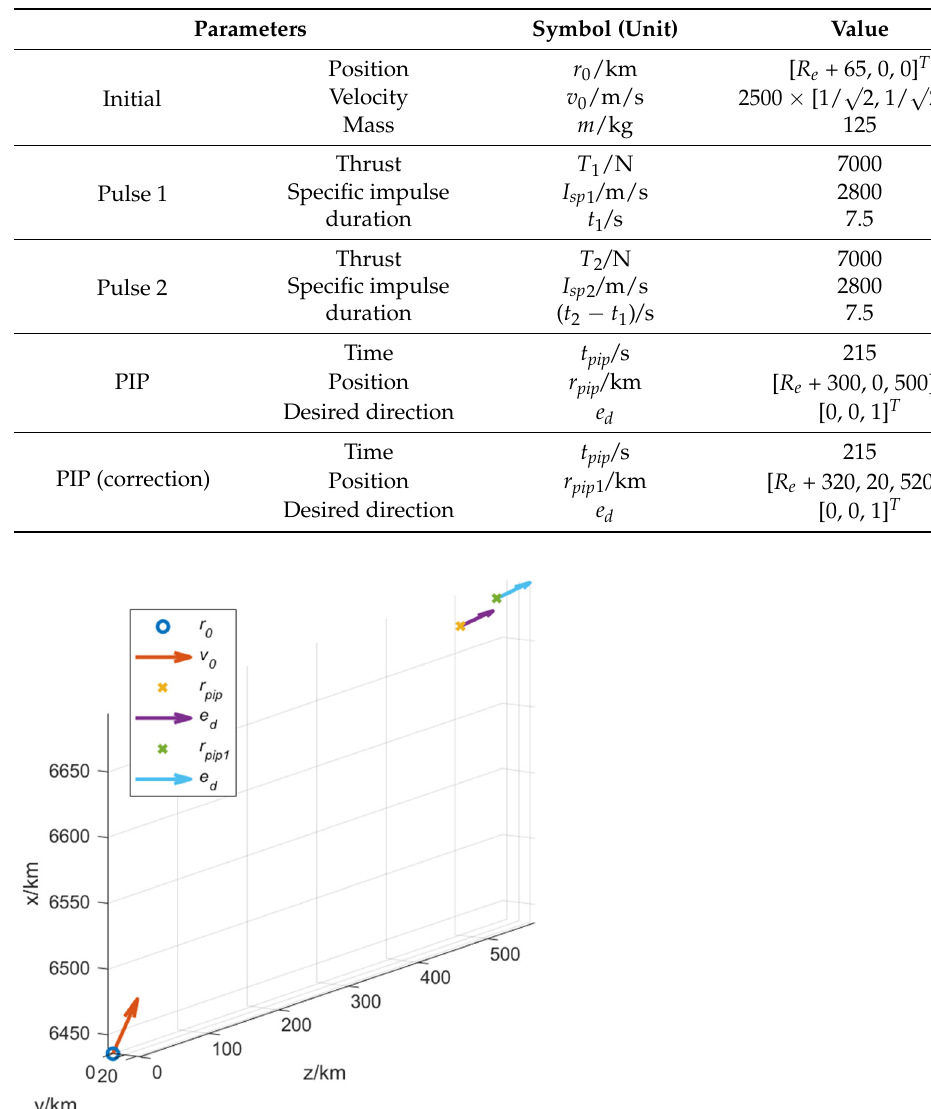
Table 1. Initial conditions of engagement.